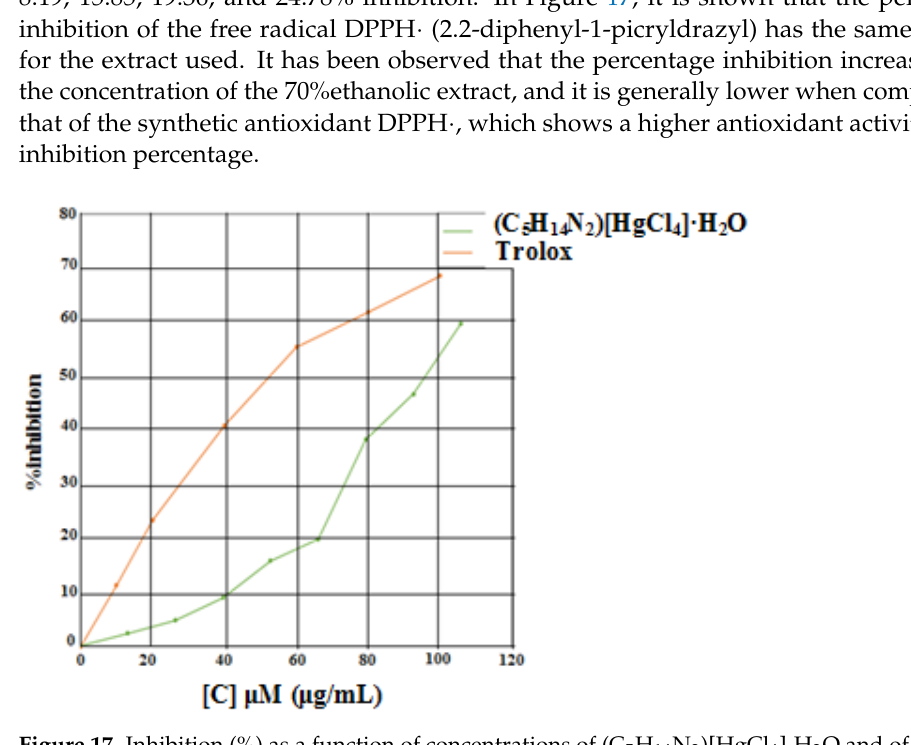
Figure 17. Inhibition (%) as a function of concentrations of (C 5 H 14 N 2 )[HgCl 4 ] · H 2 O and of Trolox.